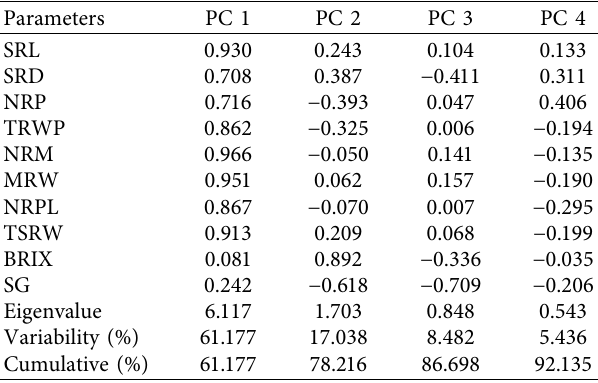
Table 5: Factor loadings, agronomic trait markers, contributed to variability in PFSP at Jatinangor Sumedang.